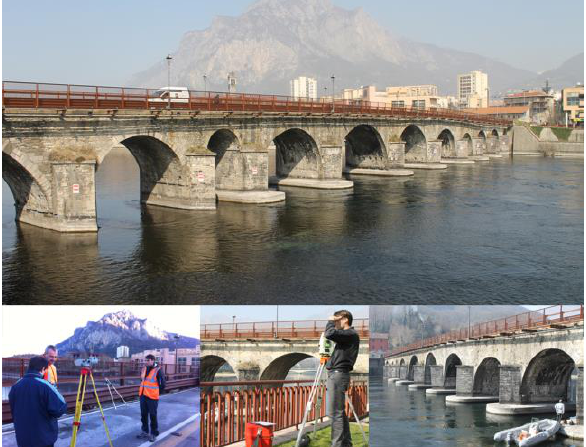
Figure 1. Azzone Visconti bridge and the 3D survey and levelling